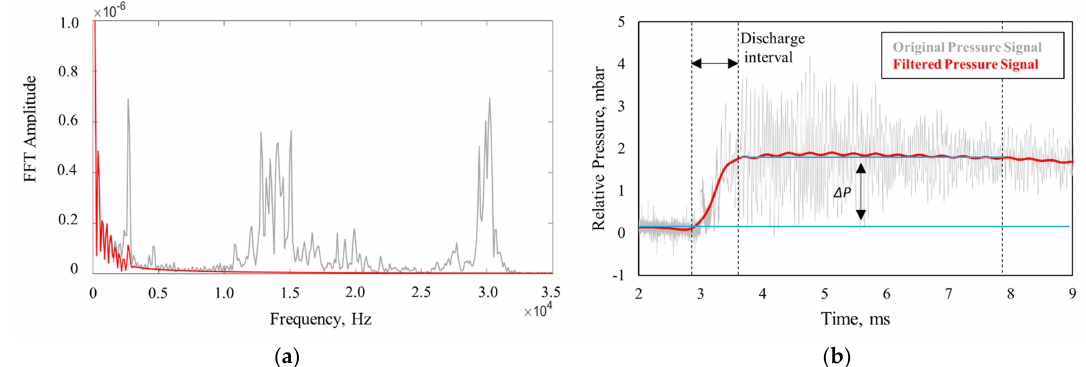
Figure 3. ( a ) FTT amplitude of the recorded pressure signal (grey signal) due to the igniter discharge and corresponding filtered signal (red line). ( b ) Corresponding pressure signals over the